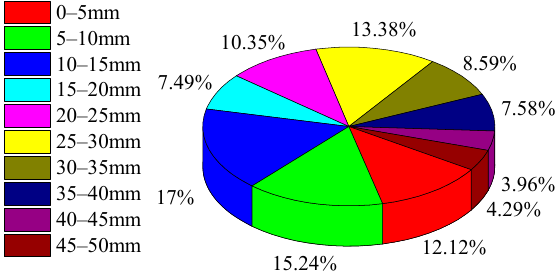
Figure 5. The distribution of the gap values in the structure.